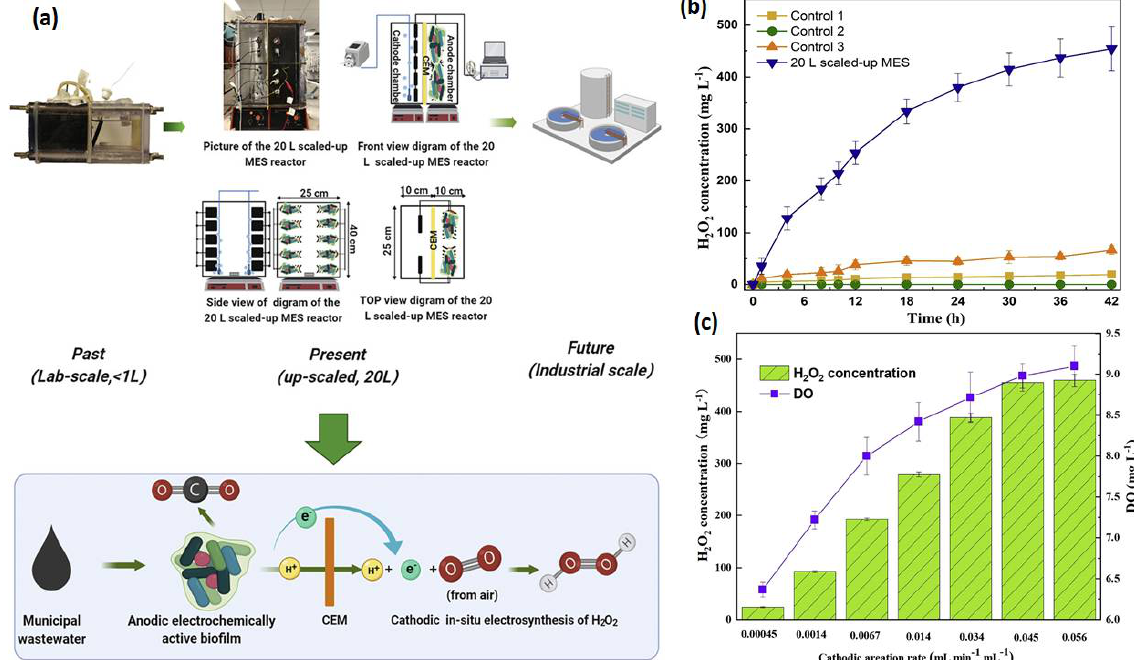
Figure 4. ( a ) Verification of this 20 L scaled-up MES reactor’s feasibility for H 2 O 2 generation. ( b ) Input and operating conditions: the electrolyte nature and concentration were 50 mM Na 2 SO 4 , the voltage was 0.6 V, the cathode aeration velocity was 0.045 mL min −1 mL −1 , and the original catholyte pH was 3. There was no cathodic aeration in control 1. The circuit for control 2 was broken. Control 3: no voltage input. H 2 O 2 production was affected by cathodic aeration velocity. Input voltage of 0.6 V, initial catholyte pH of 3, and electrolyte nature and concentration of 50 mM Na 2 SO 4 were used as operating conditions [34]. ( c ) Effect of cathodic aeration velocity on H 2 O 2 production. Operating conditions: input voltage of 0.6 V, initial catholyte pH of 3, and electrolyte nature and concentration of 50 mM Na 2 SO 4 , respectively. (Reprinted with permission from [34]. Copyright 2021,